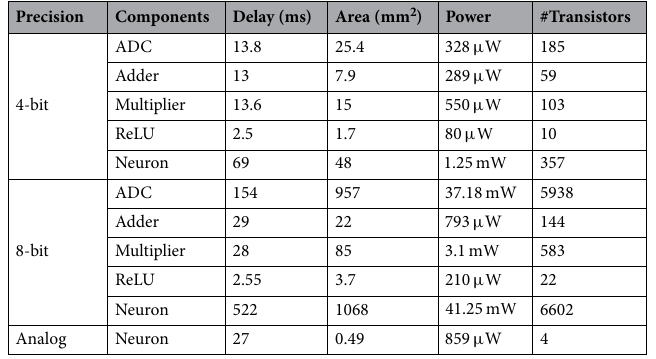
Table 1. Comparison between proposed ANN components (ADC: Analog–Digital-Converter, ReLU: Rectified Linear Unit) and conventional digital implementation. The numbers for the neuron are for a 3-input neuron design. In the case of the digital implementation (4-bit and 8-bit), the computations (addition and multiplication) are performed